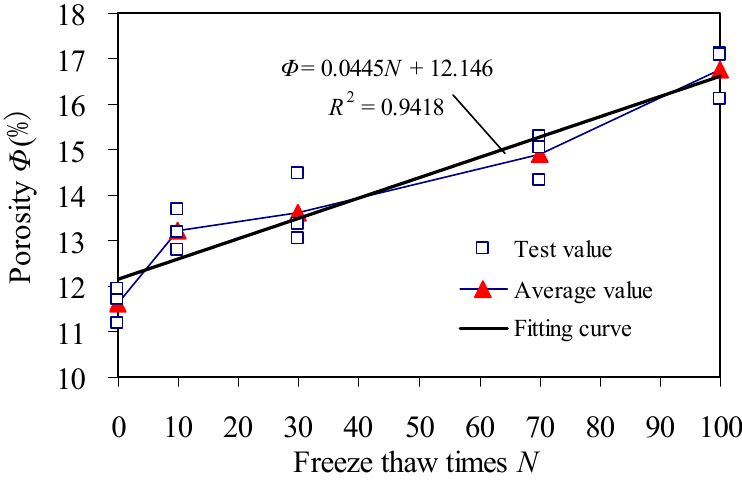
Figure 8. Porosity of red sandstone.